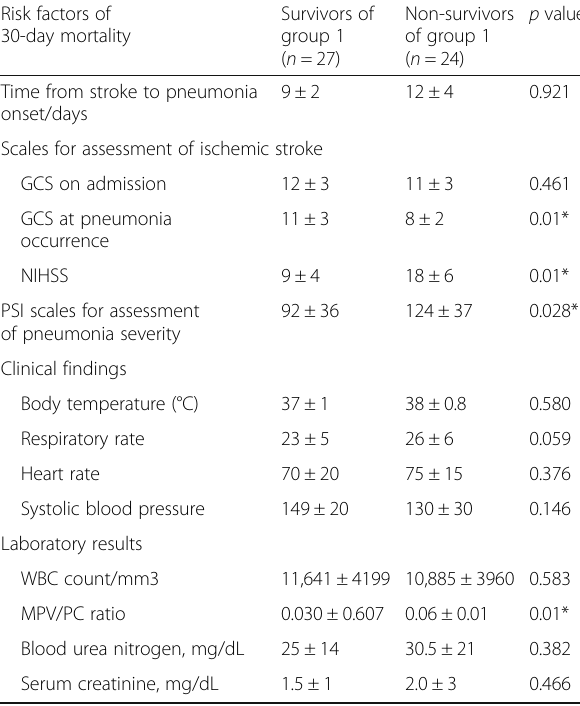
Table 2 Number and percentage of survivors versus non-survivors of group 1 regarding PSI and CURB-65 scales Scale of Survivors patients with assessment pneumonia 27 (53%)